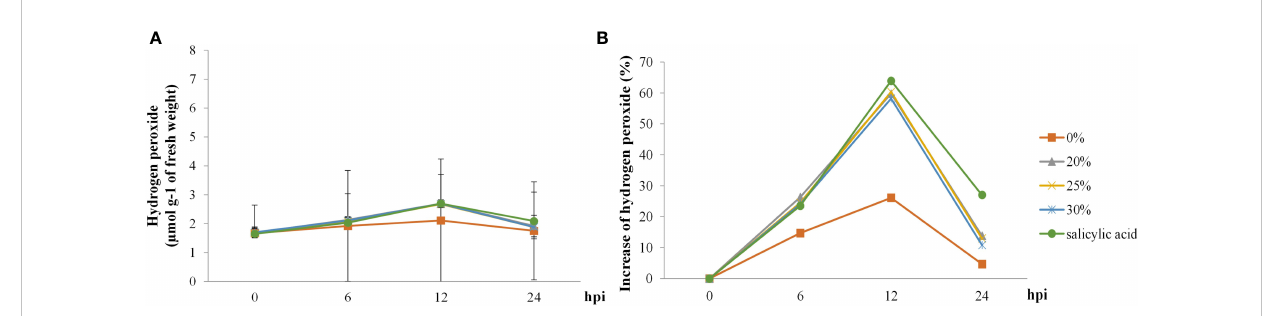
FIGURE 7 The hydrogen peroxide activity in ‘ KDML 105 ’ treated with biosurfactant following Magnaporthe oryzae infection. (A) hydrogen peroxide content and (B) relative increase in hydrogen peroxide